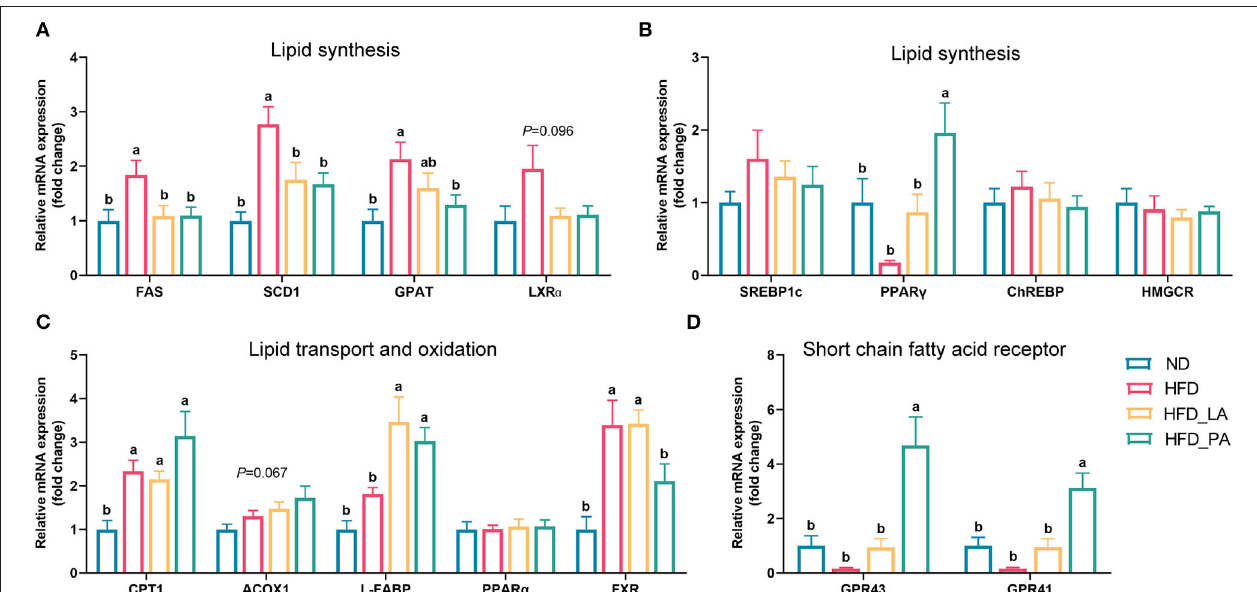
FIGURE 2 | Effects of Akkermansia muciniphila treatment on the relative mRNA expression of lipid metabolism-related genes in the livers of laying hens with fatty liver hemorrhagic syndrome (FLHS) ( n = 10). (A,B) mRNA expression levels of genes involved in the regulation of lipid synthesis. (C) mRNA expression levels of genes involved in the regulation of lipid transport and oxidation. (D) Relative mRNA expression of SCFAs receptors. The mRNA expression levels in the normal diet (ND) group (controls) were set as 1, and the relative fold increases were determined by comparison with the ND group. Different letters indicate significant differences at p < 0.05. FAS , fatty acid synthase; SCD1 , stearoyl-CoA desaturase 1; GPAT , glycerol-3-phosphate acyltransferase; LXR α , liver X receptor alpha; SREBP-1c , sterol regulatory element-binding protein 1c; PPAR- γ , peroxisome proliferator-activated receptor gamma; CHREBP , carbohydrate response element-binding